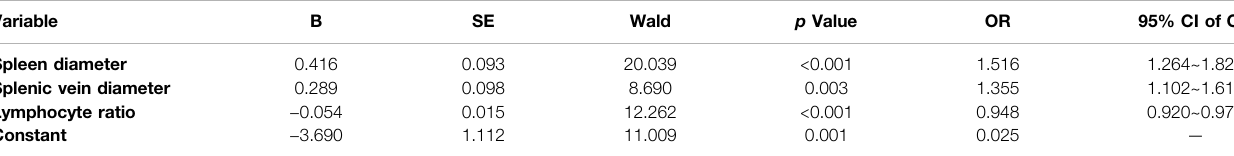
TABLE 3 | Variables used to establish the prediction model for the presence of